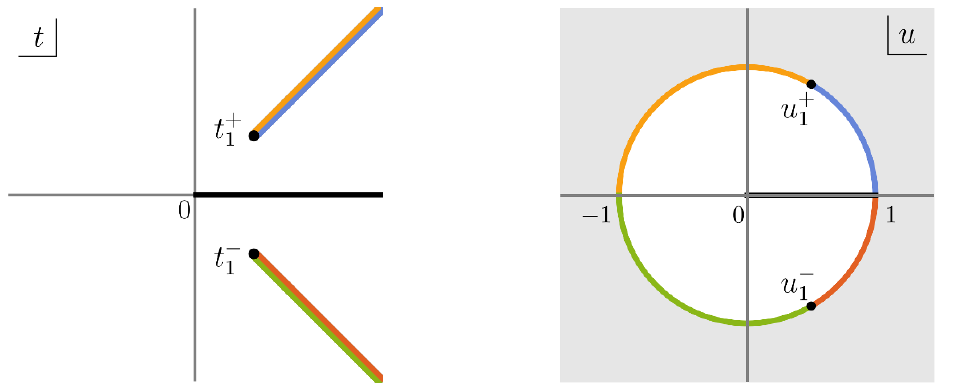
Figure 3 . The change of variable (3.6) maps the cut t -plane (left panel) into the disk of unit radius u = 1 (right panel). The branch points t (cid:6) j j t [0 ; + ) is mapped in the segment u 2 1 point at complex in(cid:12)nity are mapped to the arcs at the boundary of the disk as shown by the colors. In drawing this (cid:12)gure we picked (cid:11) 1 = 1 =